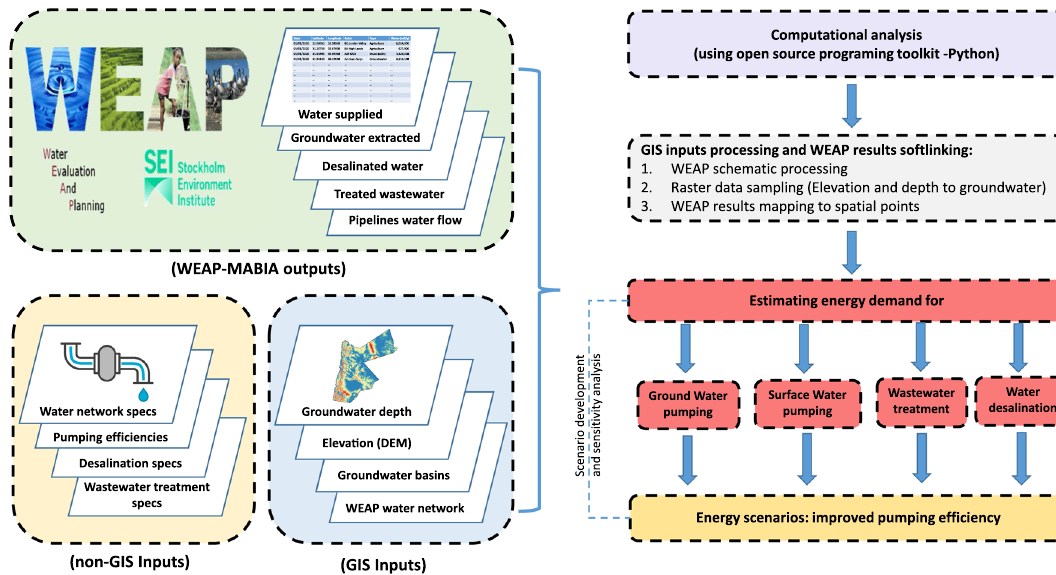
Fig. 3 GIS-based energy model—data inputs and model